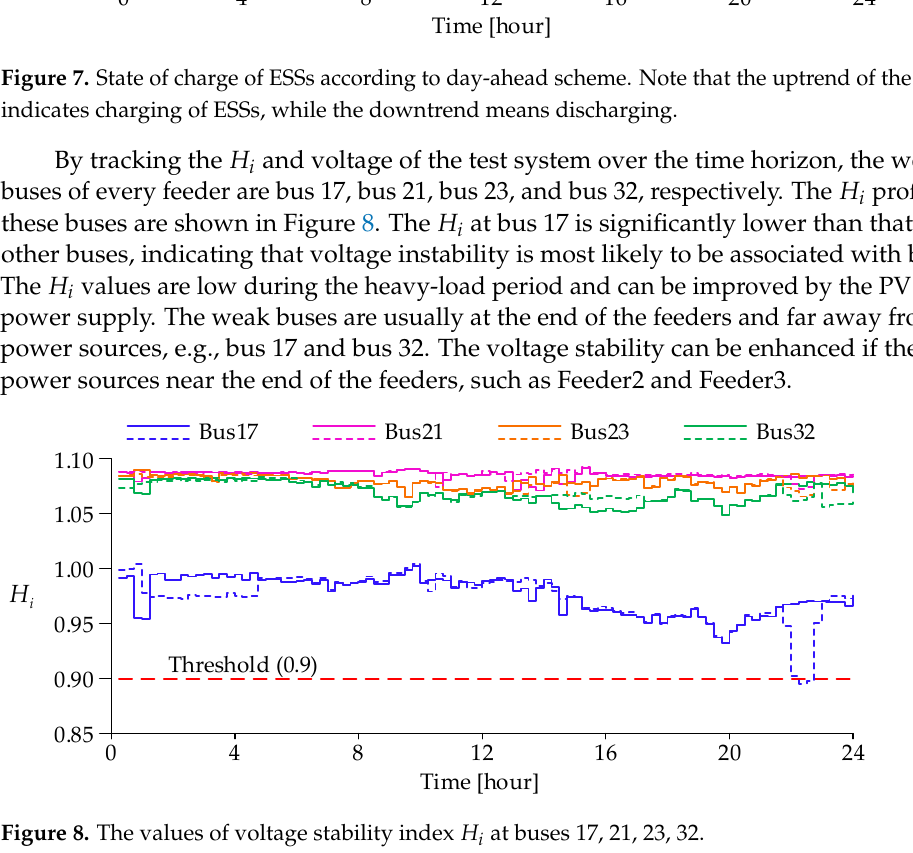
Figure 8. The values of voltage stability index H i at buses 17, 21, 23, 32.